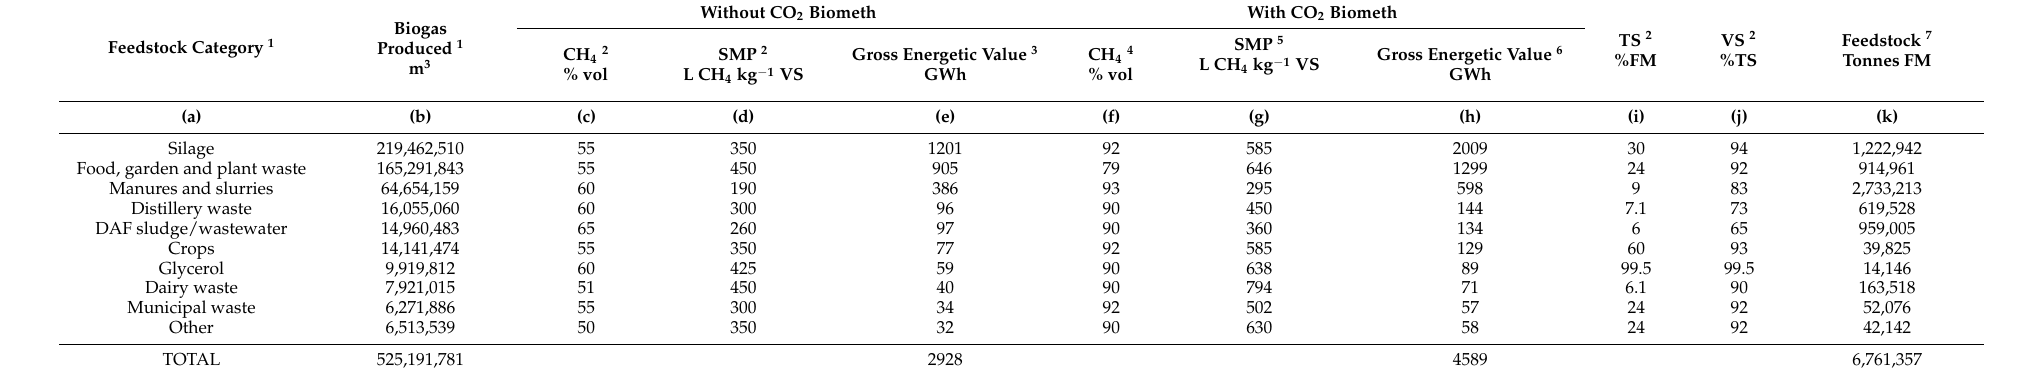
Table 2. RO AD plant feedstock characteristics with and without CO 2